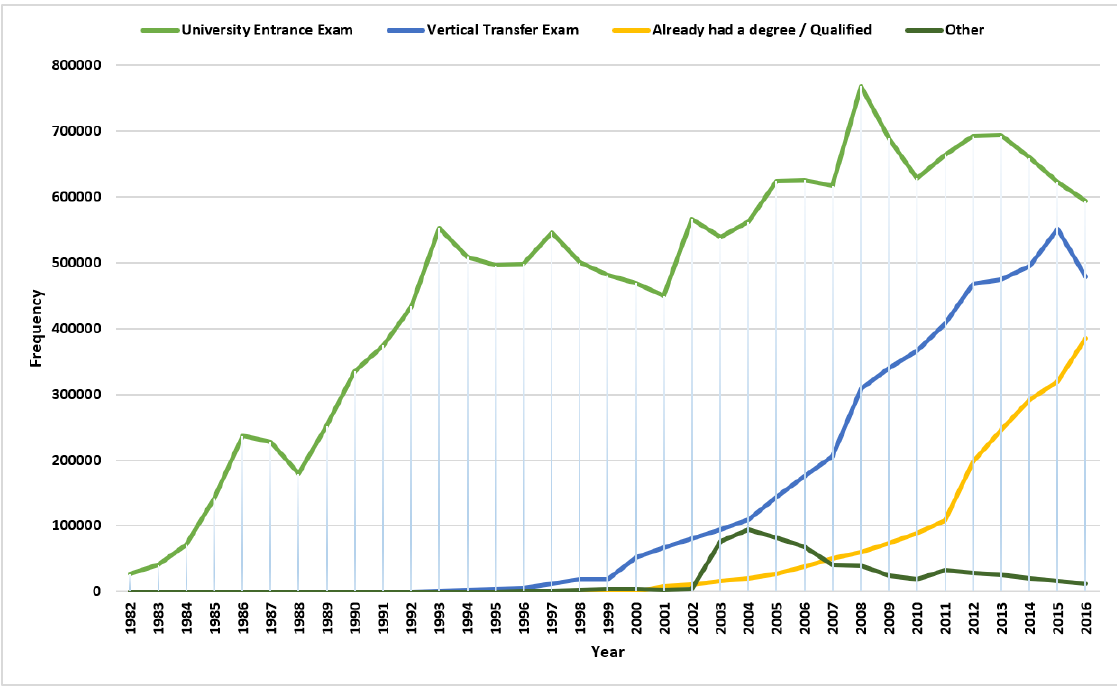
Figure 5. Enrollment types at Anadolu University